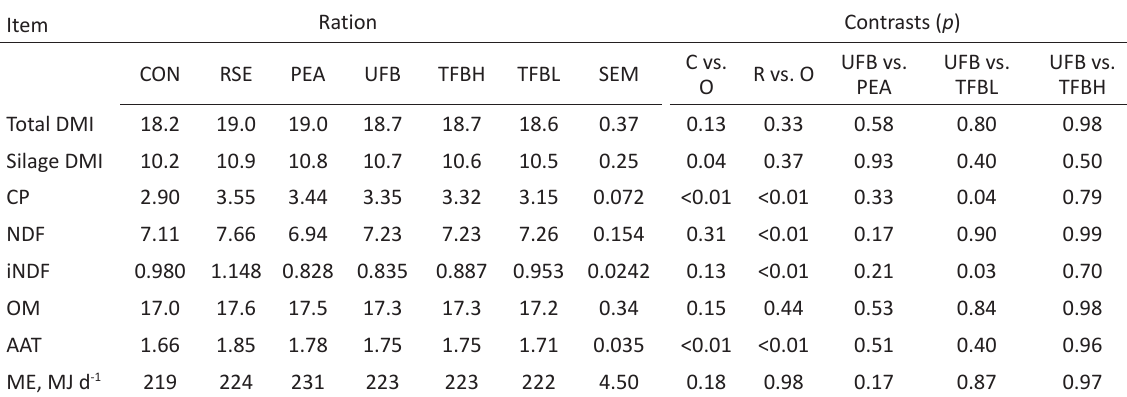
UFB vs. C vs. R vs. O PEA O 0.96